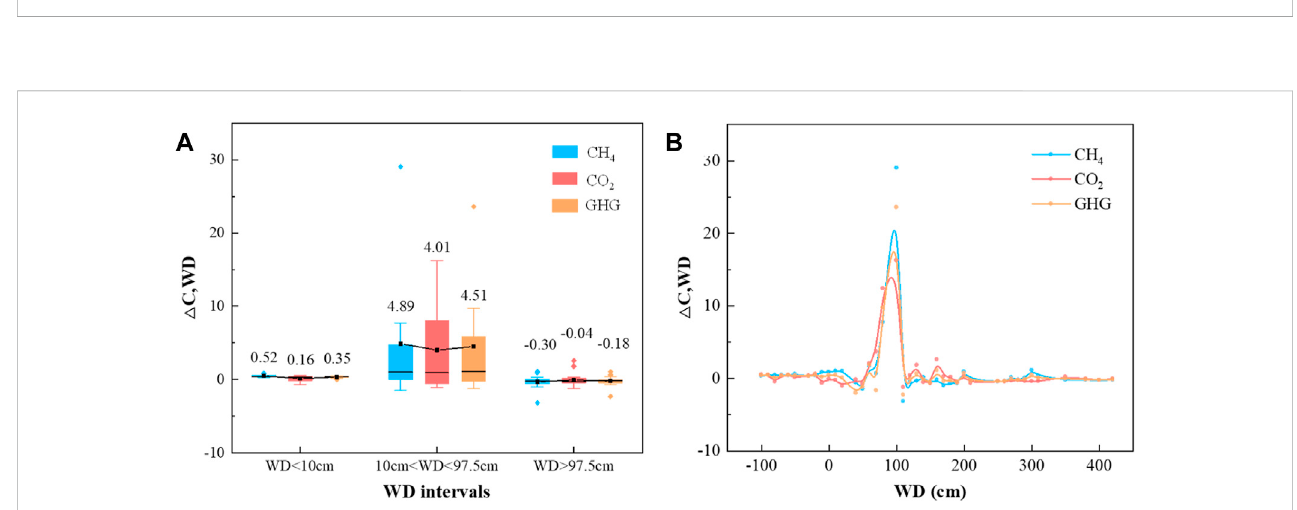
FIGURE 3 Carbonemission sensitivityvaryingwithwater depth. Figure 3Ashows theaveragesensitivityofCH 4 , CO 2 andGHGineachfocused WDinterval,andthe corresponding emission sensitivity at each water depth is described in Figure 3B.